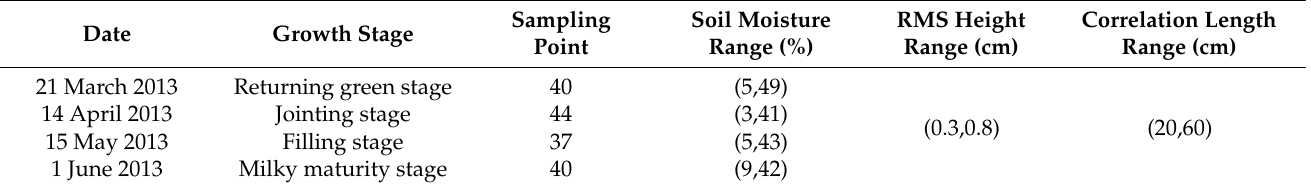
Table 1. Detailed information of four field